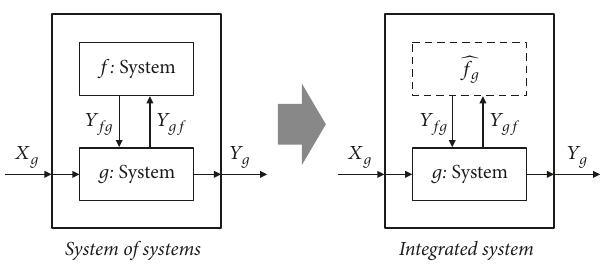
Figure 4: Systematic representation of the proposed transforma-